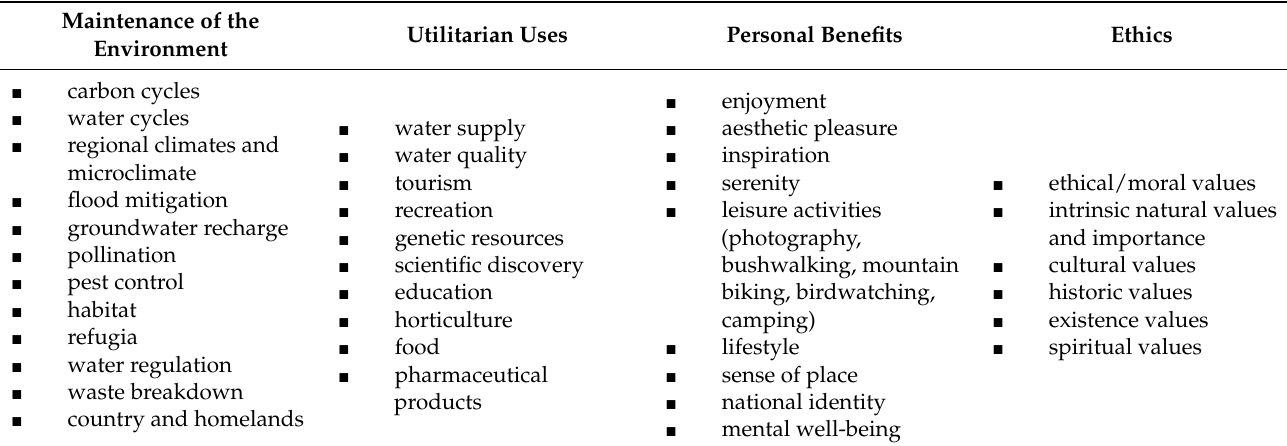
Table 2. Examples of ecosystem goods and services provided by the Wet Tropics World Heritage Area and are under threat from climate